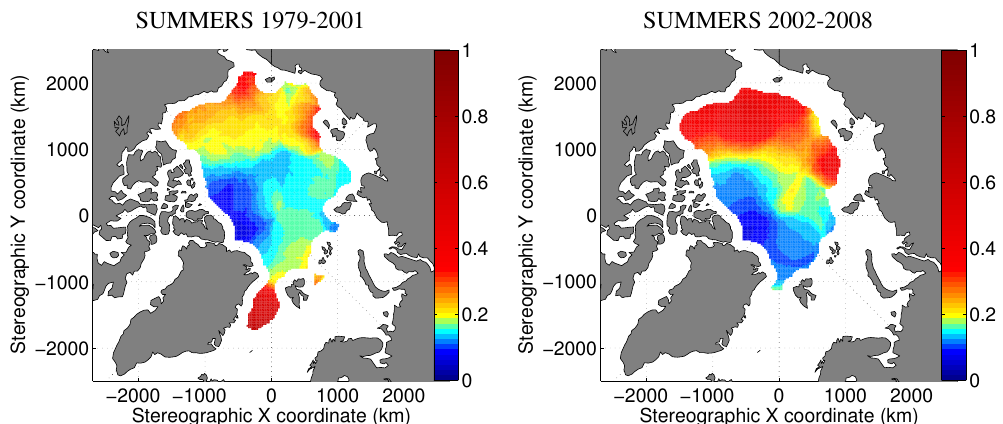
Fig. 13. Spatial repartition of open water concentration within the Arctic Basin in summer computed using the seasonal dataset of the period 1979–2001 and the seasonal dataset of the period 2002–2008. An average mean value of open water concentration, denoted 1 − α , is computed following Eq. (10) for each node of a 25km resolution grid. The smoothing parameter L is equal to 400km. In order to not represent regions with little data, an open water concentration value at a given grid point is plotted only if its associated weight is greater than a minimum value we arbitrarily set to 1000 .